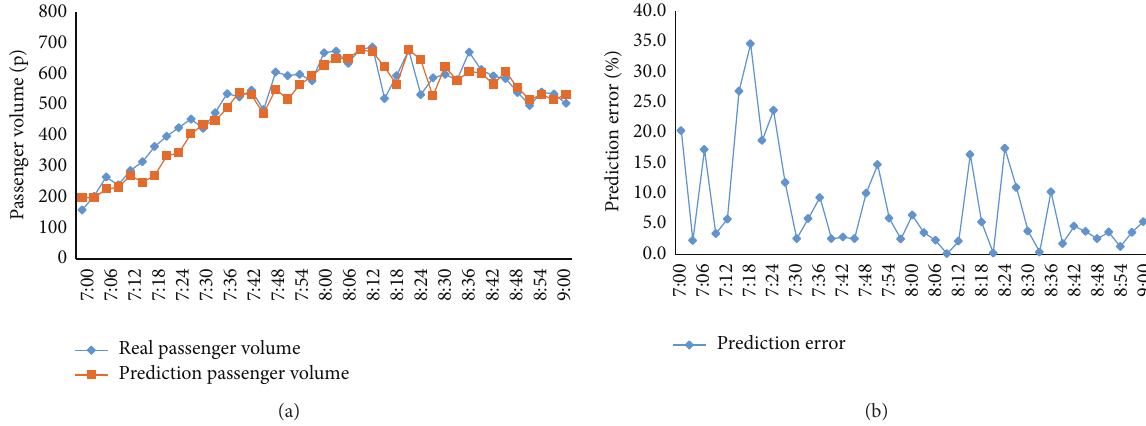
Figure 5: Forecasting result for each 3 minutes in morning peak hour using nonparametric regression.